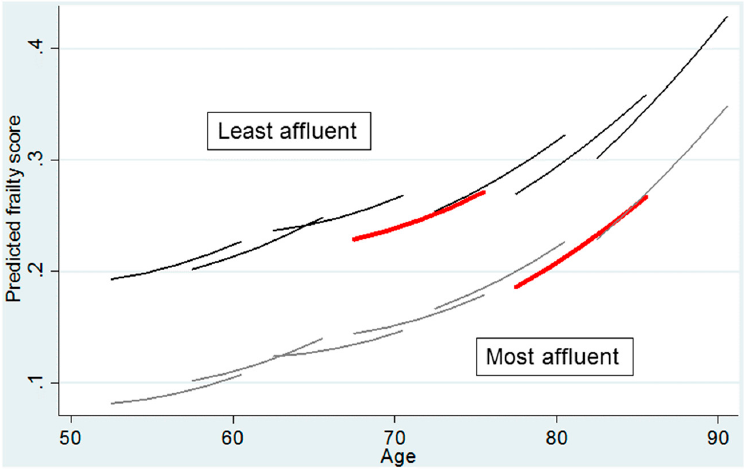
Figure 2. Frailty trajectories stratified by wealth tertile and cohort.